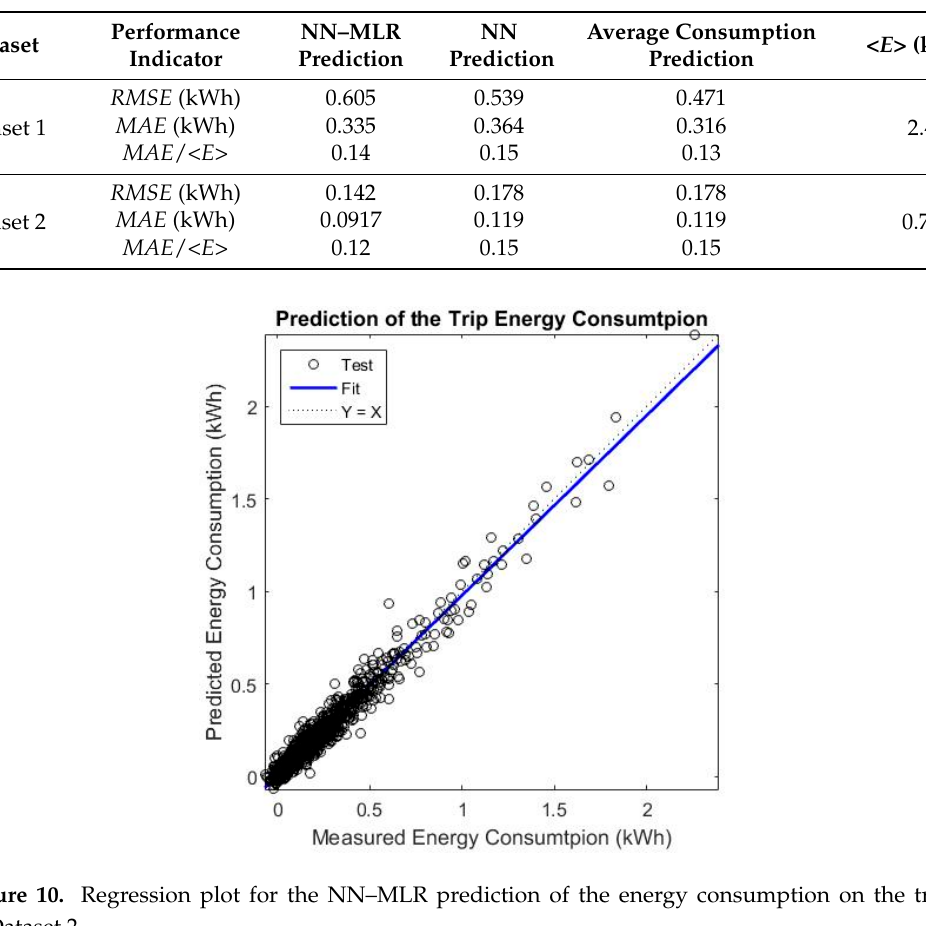
Table 6. Performance indicators MLR energy estimation model on trip and segment level by considering the measured CMF and aerodynamic predictor as input.